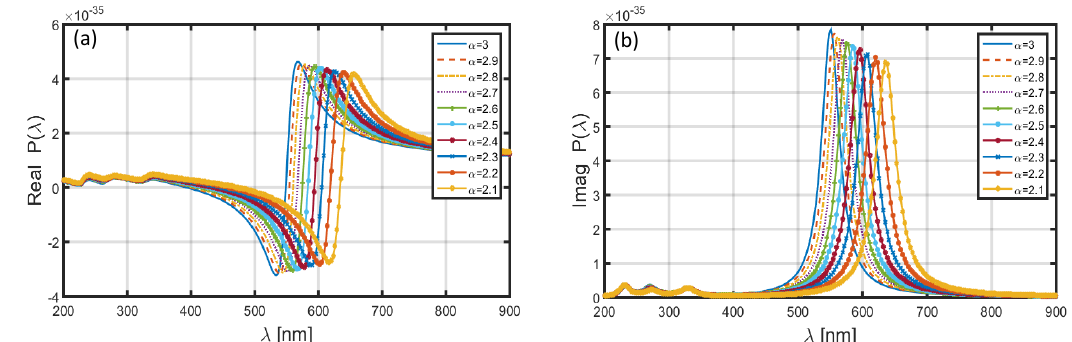
Figure 5. Wavelength-dependence of the ( a ) real and ( b ) imaginary parts of polarizability of the nanoparticle coated with Ag.